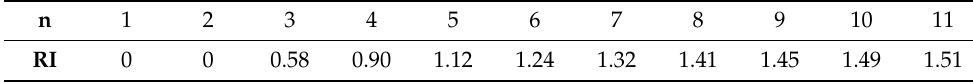
Table 1. Average random consistency index